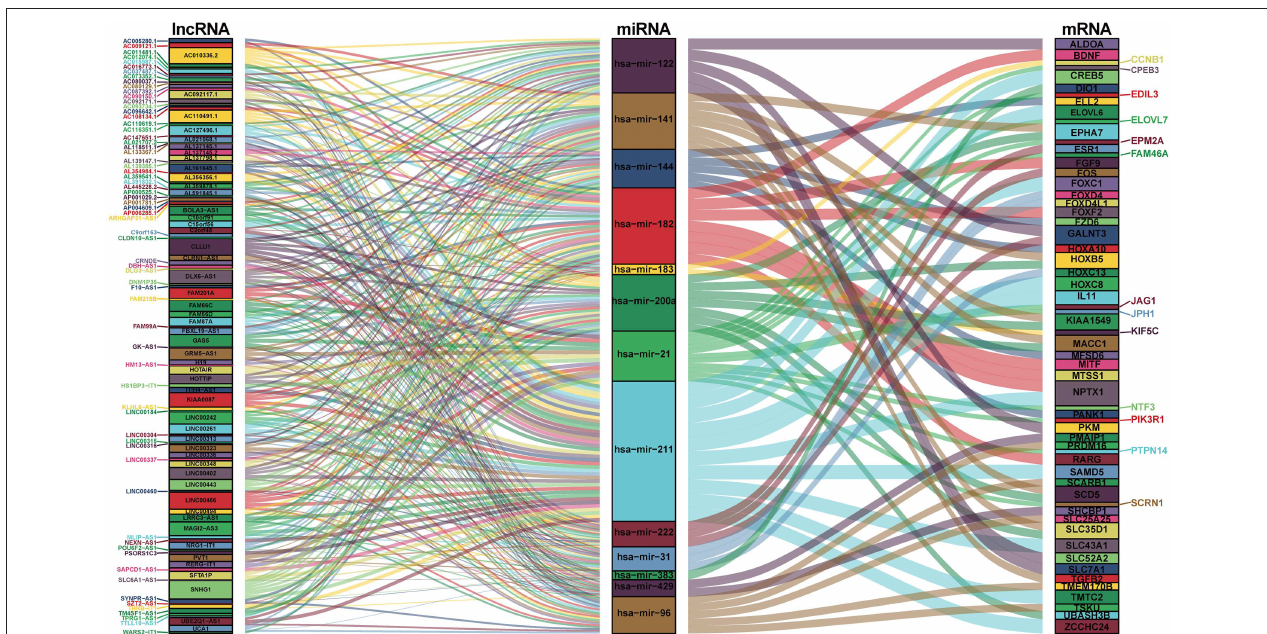
FIGURE 2 | Sankey diagram for the ceRNA network in cholangiocarcinoma. Each rectangle represents a gene, and the connection degree of each gene is displayed based on the size of the rectangle.